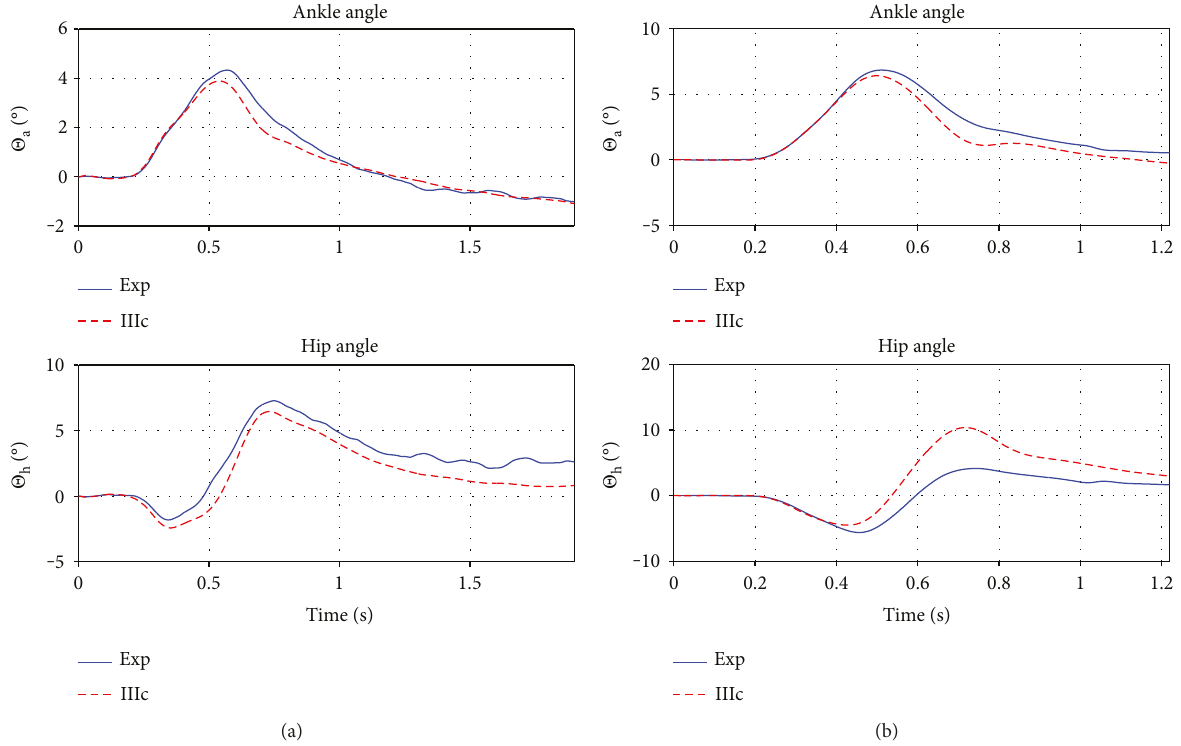
Figure 9: Best (a) and worst (b) prediction on S . Plotted are the ankle and hip angle in deg. over time in seconds. The red/dashed lines are the tr . On the test set, the averaged controller ranged experimental trials, and the blue/solid lines are the corresponding simulation of controller IIIc avrg in quality of reproduction between those two trials. Obviously the prediction is good, since the test set trials were used to fi nd the parameters X